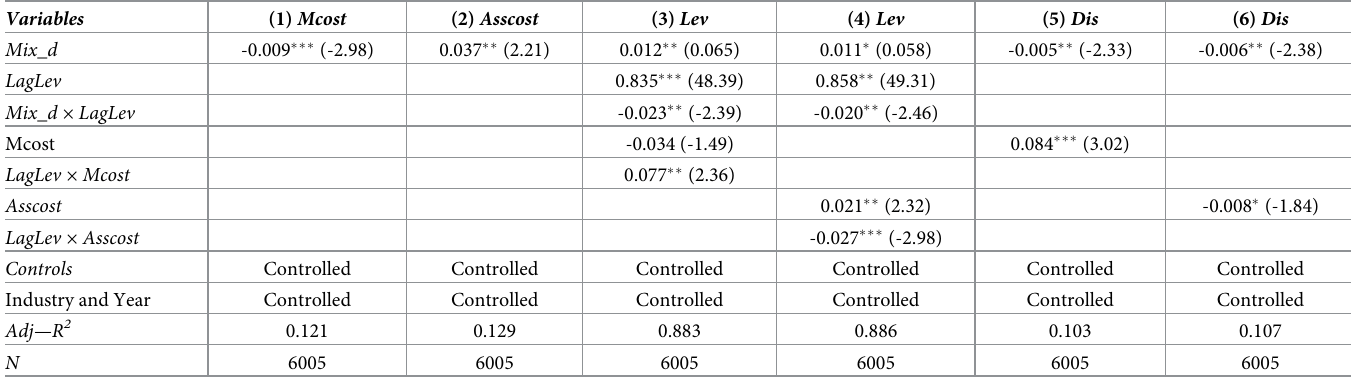
Table 10. Mediation test